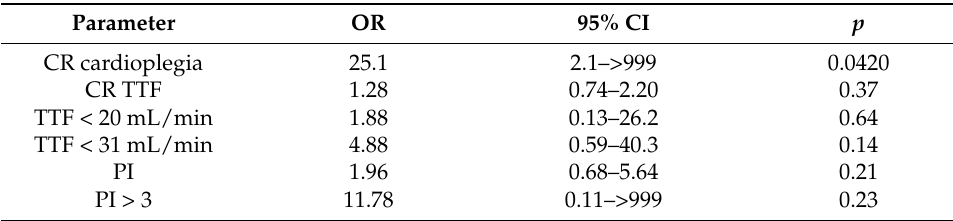
Table 4. Univariate logistic regression model to predict graft occlusion.